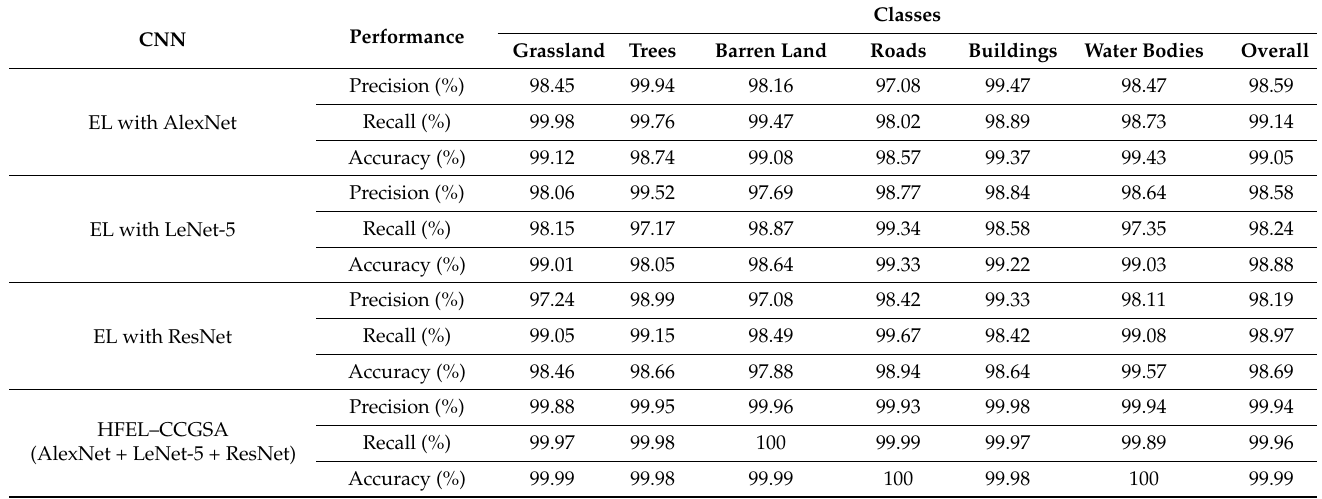
Table 5. Performance analysis for individual CNNs and HFEL–CCGSA (AlexNet + LeNet-5 + ResNet) on SAT-6 dataset.